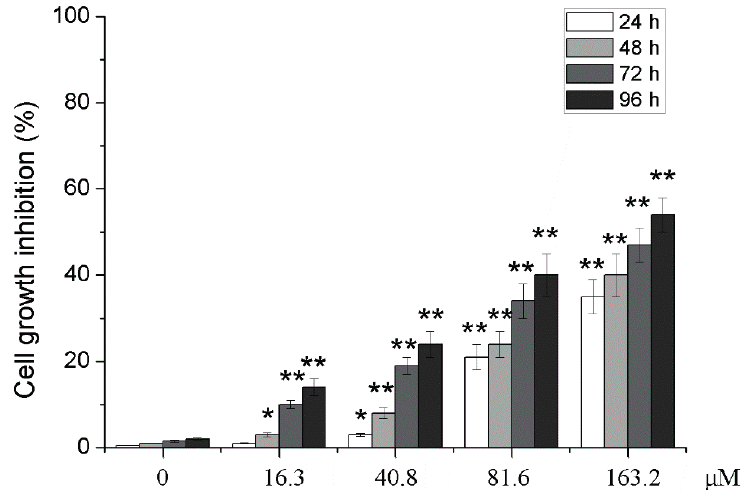
Figure 2. Effects of PD on cell growth inhibition of U251. U251 cells were treated with 0, 16.3, 40.8, 81.6 and 163.2 μ M of PD for 24, 48, 72 and 96 h. Cell growth inhibition was measured by using MTT assay. Each value is presented as mean ± SD ( n = 3). * p < 0.05 compared with 0 μ M PD; ** p < 0.01 compared with 0 μ M